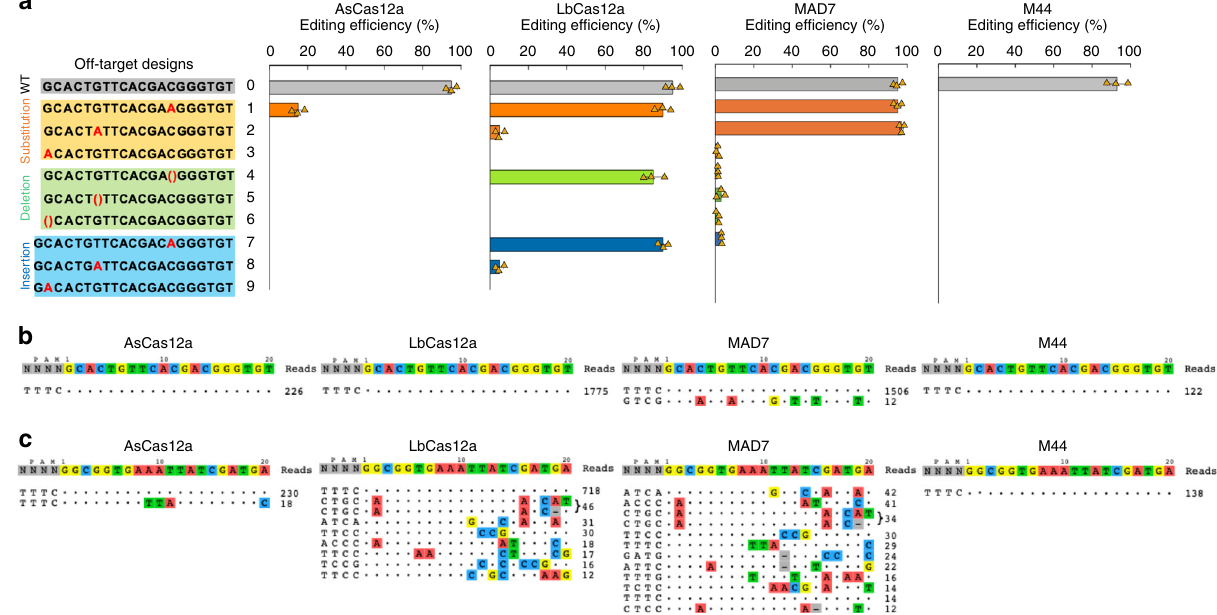
Fig. 5 The off-target assay for chimeric Cas12a-type variants. a The individual off-target assay. We designed nine different off-target spacers, of which three were substitutions, three were deletions, and three were insertions. b , c Genome-wide off-target analysis was done using the CIRCLE-seq method 56,57 . b gRNA targeting the galK1 site and c gRNA targeting the lacZ2 site. Positions with mismatches to the target sequences, i.e., off-target sites, are highlighted in color. CIRCLE-seq read counts are shown to the right of the on- and off-target sequences and represent a measure of cleavage ef fi ciency at a given site. The on/off-target reads shown in the fi gure were higher than 10. Source Data are available in the Source Data File.